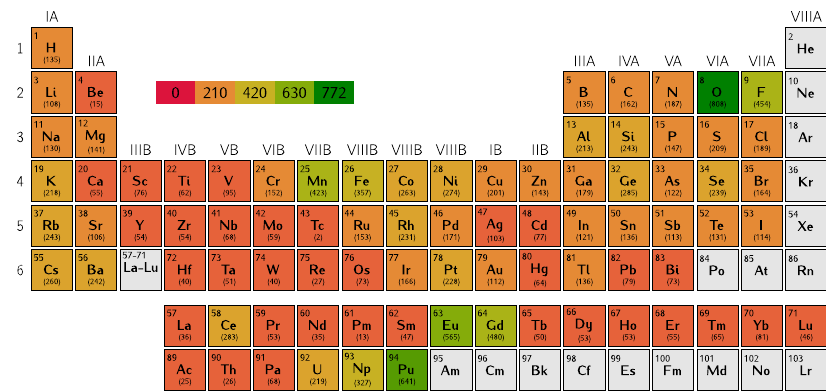
Fig. 6 Distribution of magnetic systems. The number of magnetic systems containing a given element of the periodic table.